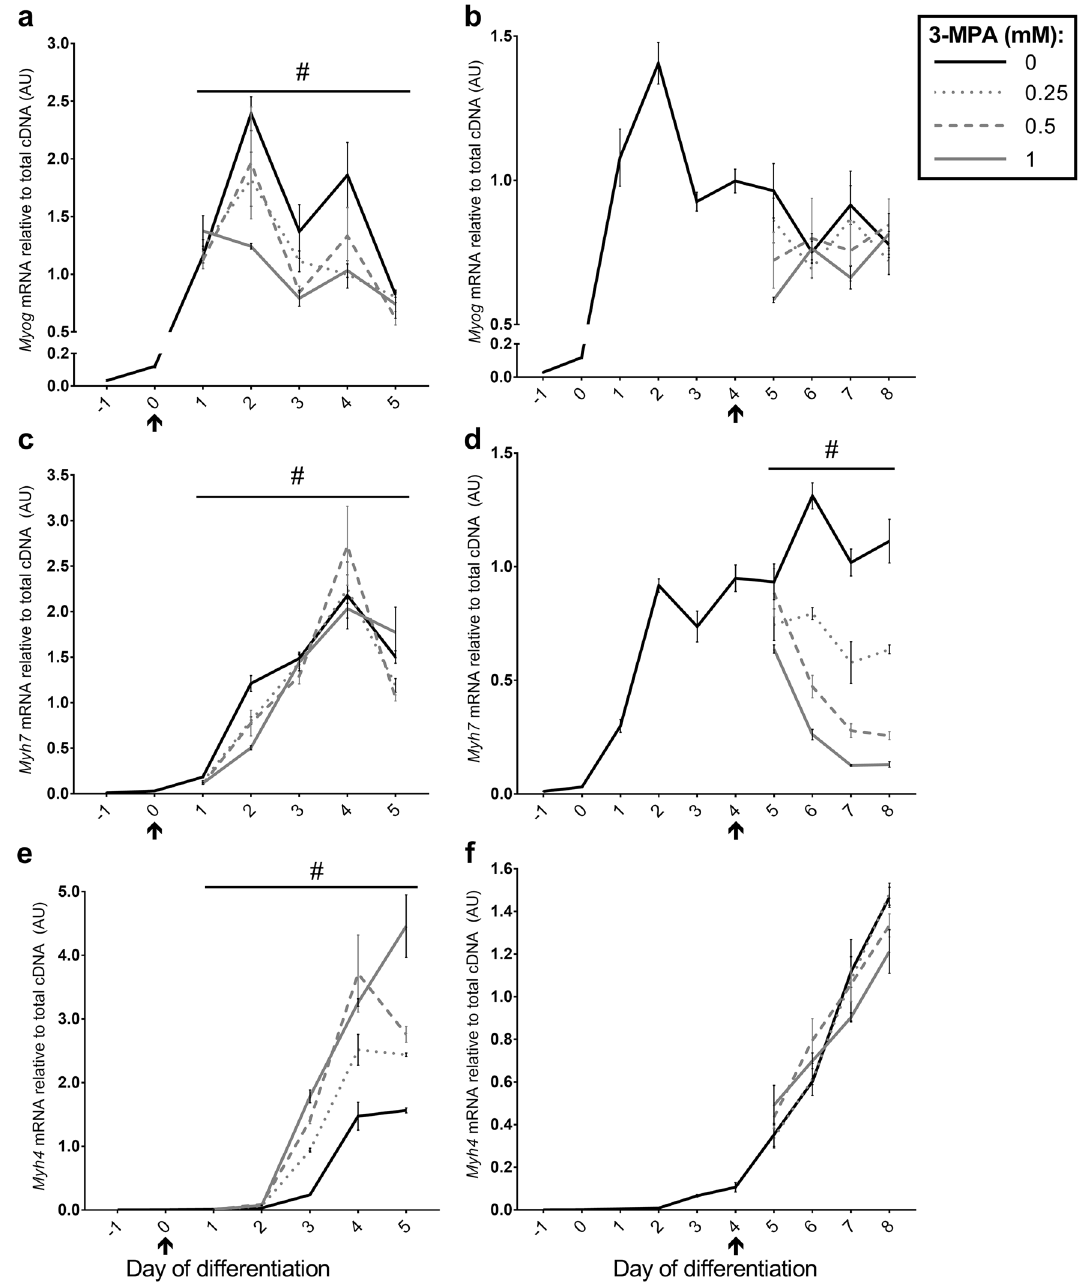
Figure 4. Effect of 3-MPA treatment on genes associated with myogenesis. Relative expression of ( a , b ) Myog (Myogenin), ( c , d ) Myh7 (encodes Myosin Heavy Chain (MyHC)-I), and ( e , f ) Myh4 (encodes MyHC-IIB) mRNA following treatment of C2C12 cells with 0, 0.25, 0.5 or 1 mM 3-MPA from day 0 ( a , c , e ) or day 4 ( b , d , f ) of differentiation. Data presented as Means (n = 4–6) ± SEM. # P < 0.05 (time × treatment interaction). Start of treatment indicated by ↑ . See Supplementary Tables 1 and 2 for Dunnett’s Multiple Comparison